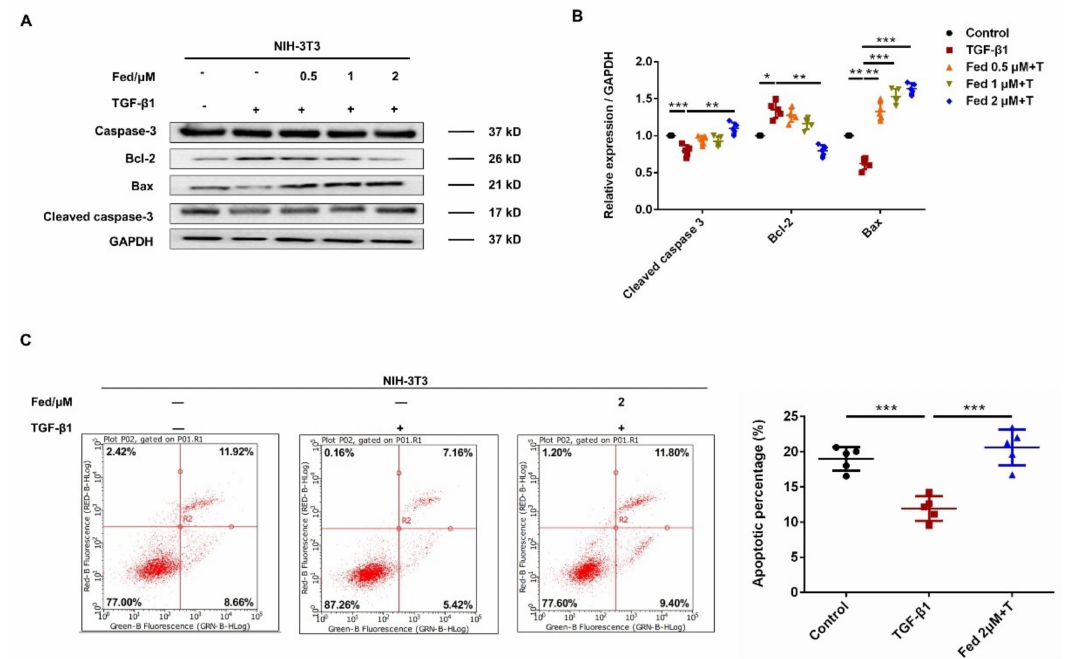
Figure 5. Fedratinib suppresses TGF- β 1-induced myofibroblast apoptosis resistance. ( A , B ) NIH-3T3 cells were treated with TGF- β 1 (5 ng/mL) and Fed (0.5, 1 and 2 µ M) for 24 h. The protein levels of caspase-3, Bcl-2 and Bax were analyzed by Western blot. GAPDH was used as a loading control in grayscale analysis. ( C ) NIH-3T3 cells were treated with TGF- β 1 (5 ng/mL) and Fed (2 µ M) for 24 h. The percentage of apoptosis was determined by flow cytometry. Data are presented as the means ± SD ( n = 5). Comparisons between groups were achieved using one-way analysis of variance (ANOVA). * p < 0.05, ** p < 0.01, *** p <